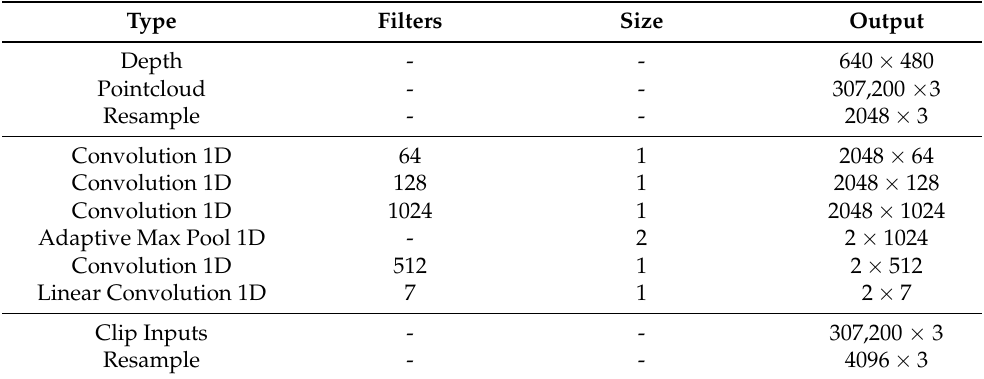
Table 2. Architecture of the clipping network. The last convolutional layer does not contain the activation function because finding bounding boxes is a regression task.